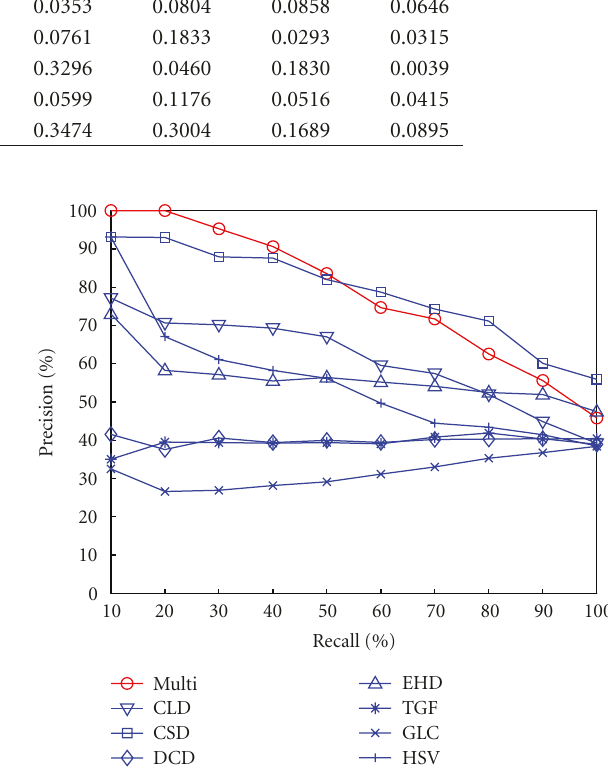
Figure 9: Precision-recall curves for concept cloud using the multi- feature combination metric and using single